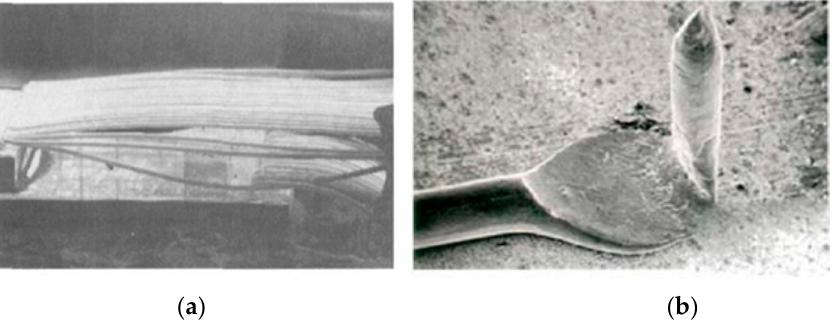
Figure 1. The phenomenon of wire ( a ) collapse and ( b ) tailing of Au bonding wire [23]. Reproduced with permission from Ref. [23]; published by Precious Metals, 2017. As IC packaging develops toward miniaturization, high-density, and large-span ratio by leaps and bounds, higher demands are placed on the wire diameter, hardness,